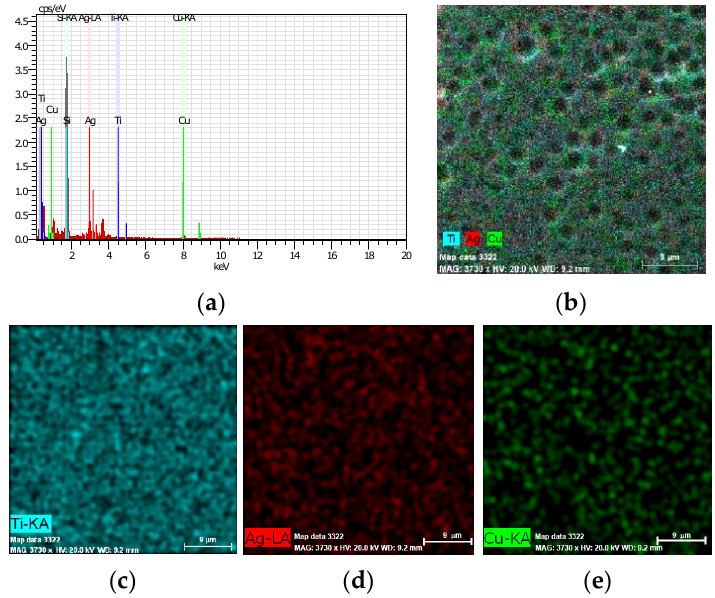
Figure 1. EDX spectrum ( a ), integrated map of Ti, Ag and Cu distribution ( b ) and maps of the individual elements Ti ( c ), Ag ( d ), Cu ( e ) distribution in Sample 5—TiO 2 /Ag 23.1 at.% /Cu 21.6 at.% .